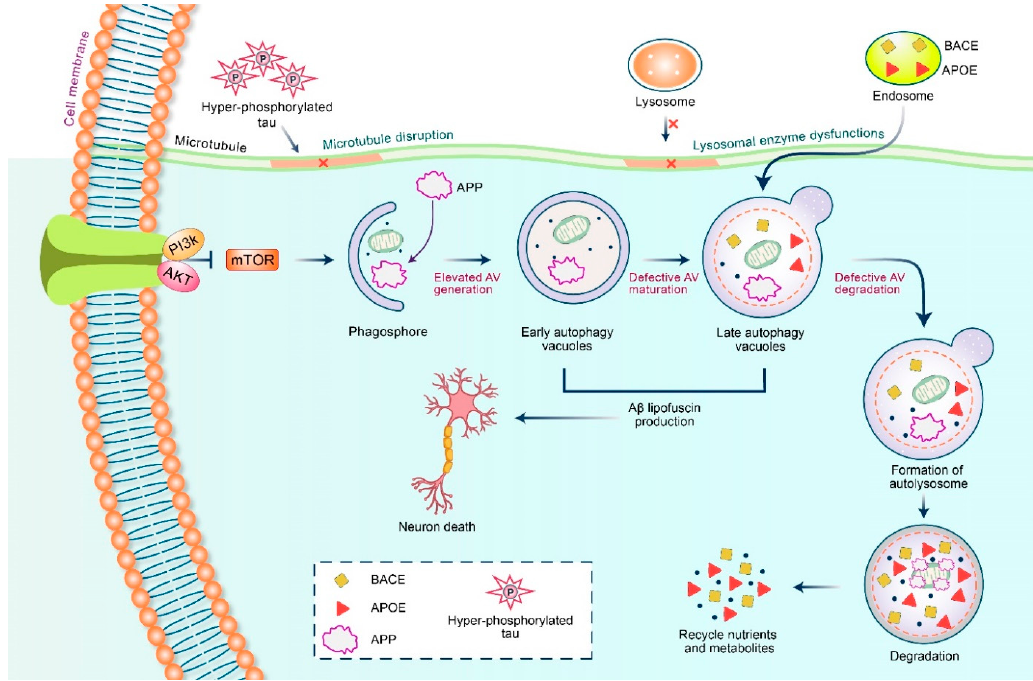
Figure 5. APP, BACE, and ApoE are AD-related molecules and eliminated by autophagy. In the initial stage of AD, autophagic vacuoles (AVs) are formed due to the stress induced by APP mutants which ultimately damage the mitochondria. During the late stage of AD, maturation as well as degradation of autophagosomes are blocked by microtubule disruption which causes hyperphosphorylated tau accumulation. Tau hyperphosphorylation might inhibit microtubule assembly in addition to disrupt the preassembled microtubules. Eventually, dysfunction of lysosomal enzymes interferes with autophagosome-lysosome fusion in AD. Taken together, these defects of autophagy contribute to accumulation of AVs along with other AD-related molecules which increased intracellular A β deposition as well as lipofuscin thereby causing neuronal cell degeneration and death.